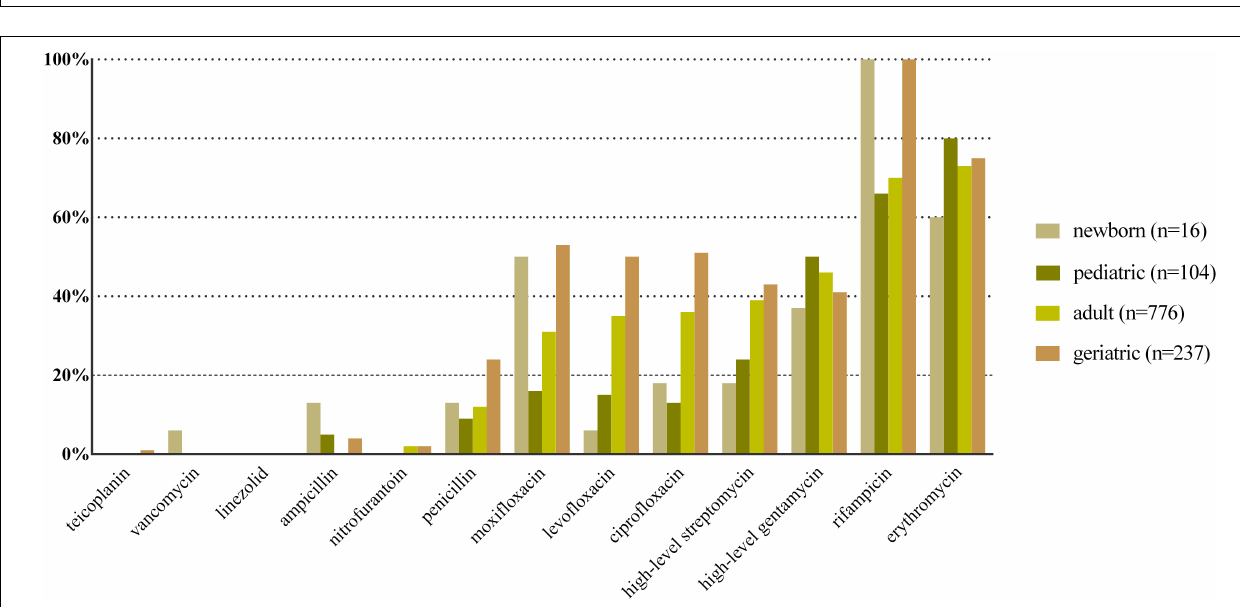
FIGURE 3 | Antibacterial resistance rates of urinary K. pneumoniae in different age categories. X -axis: different antibiotics tested for urinary K. pneumoniae , Y -axis: Antibiotic resistance rate.